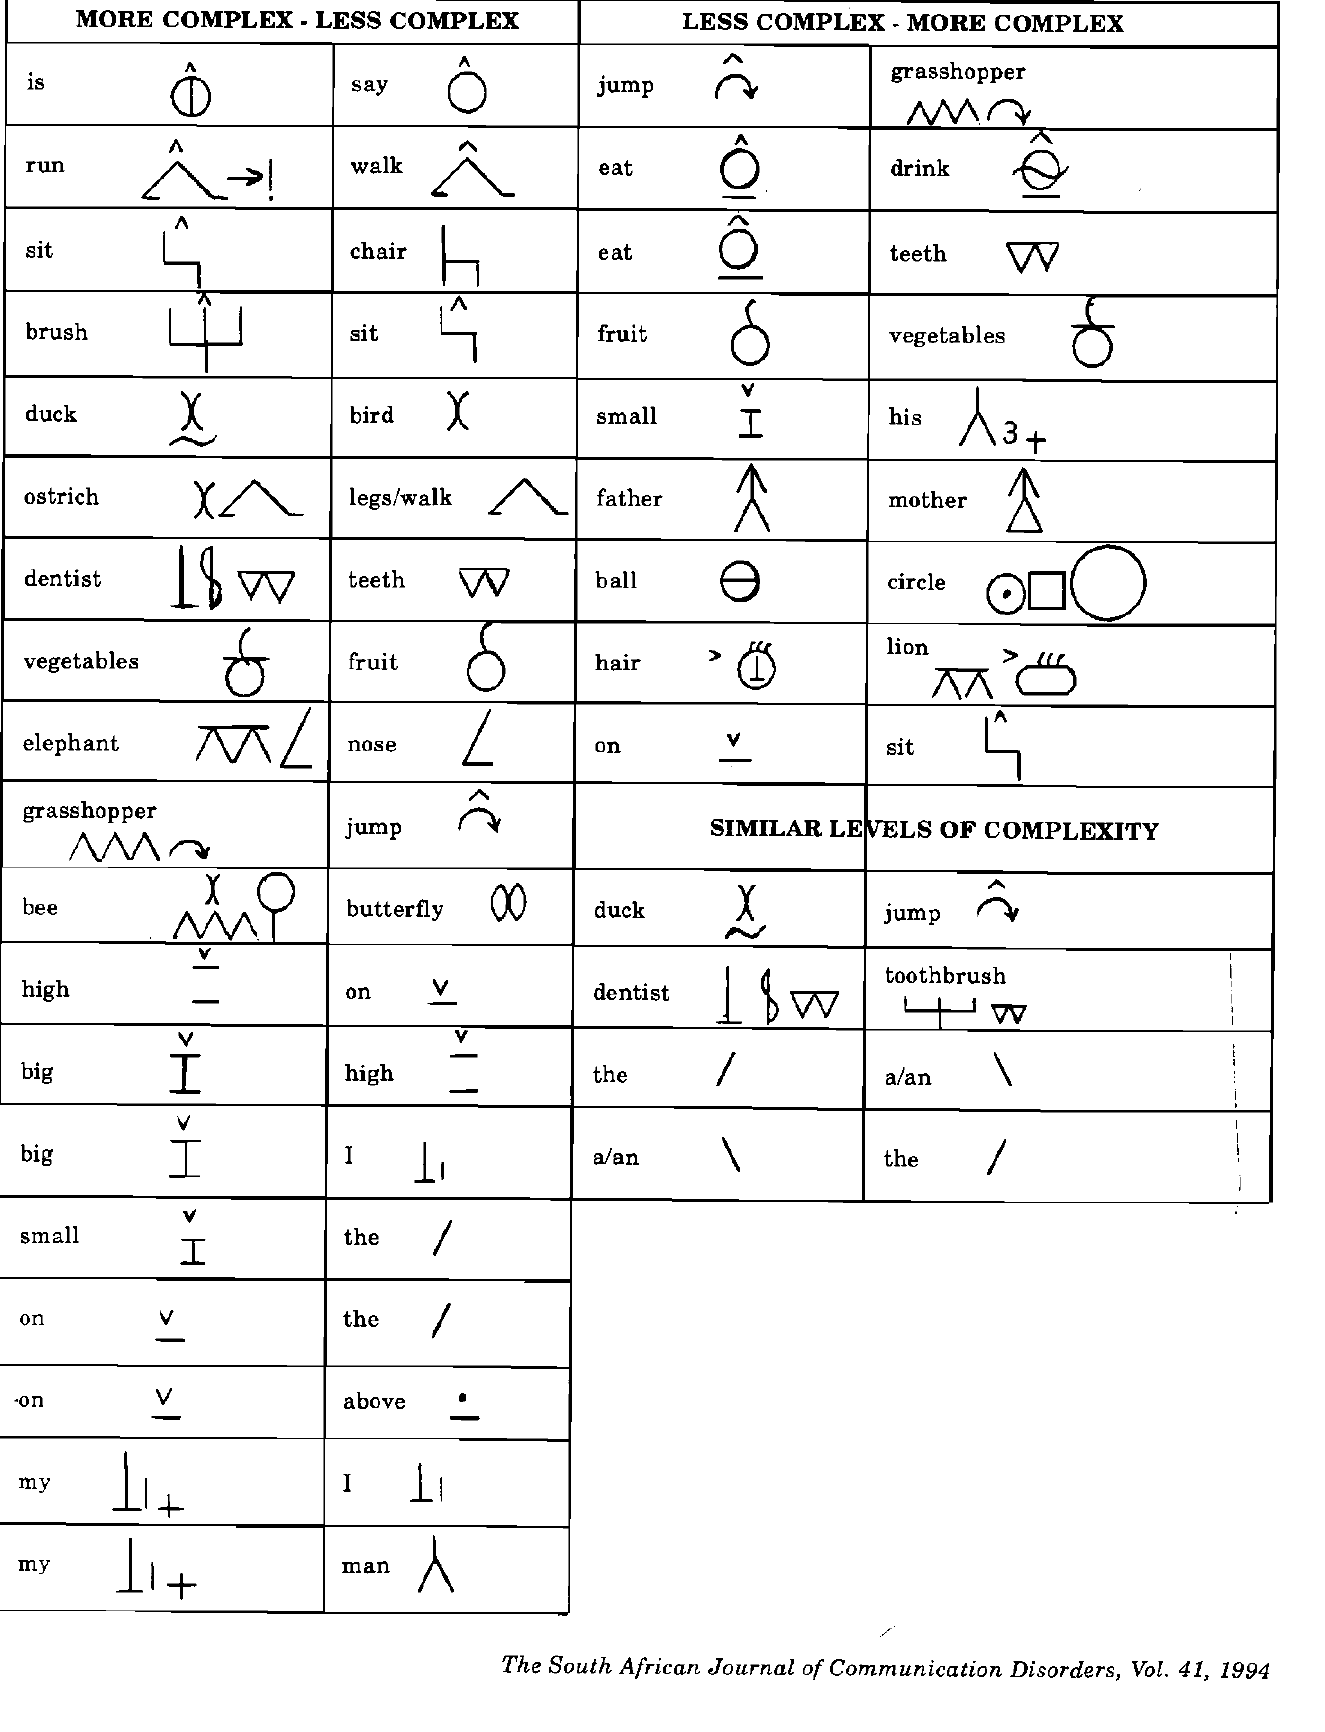
Table 4. Qualitative description of subjects' symbol errors MORE COMPLEX - LESS